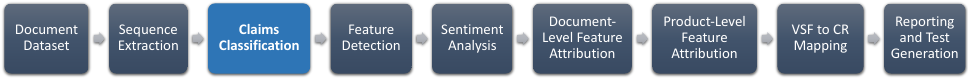
Figure 1. Overall workflow of the CYVET cybersecurity vetting